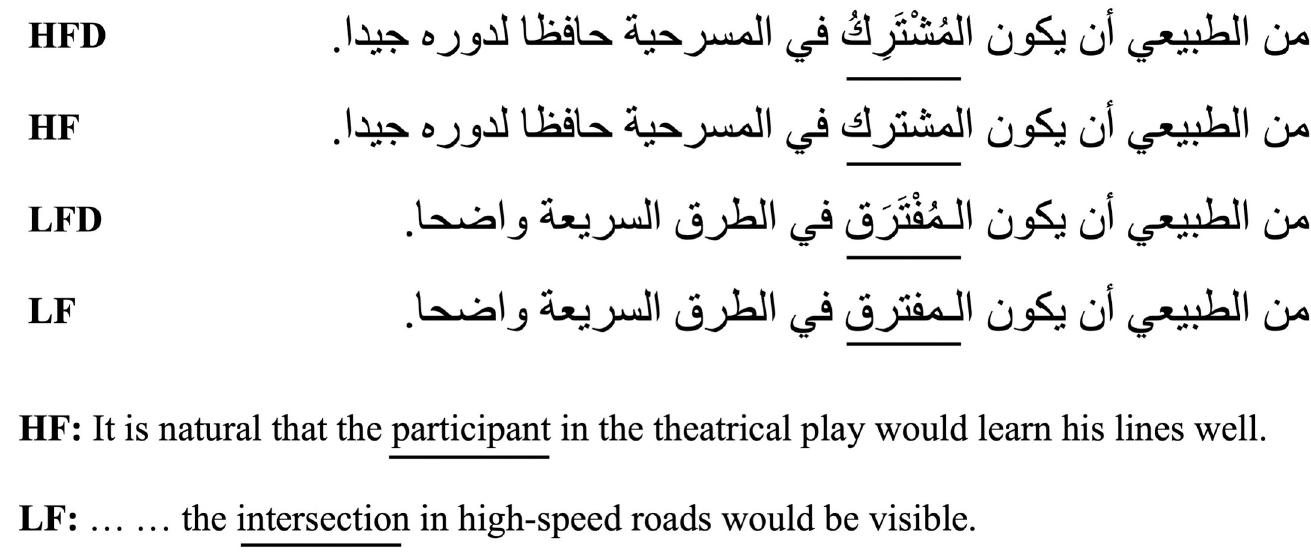
Fig 1. A sample stimuli set for Experiment 1. The target words are underlined in the Arabic frame sentences and the English translation. HF and LF are high- and low frequency target words conditions, respectively, and HFD and LFD are diacritized high- and low frequency target words conditions, respectively.